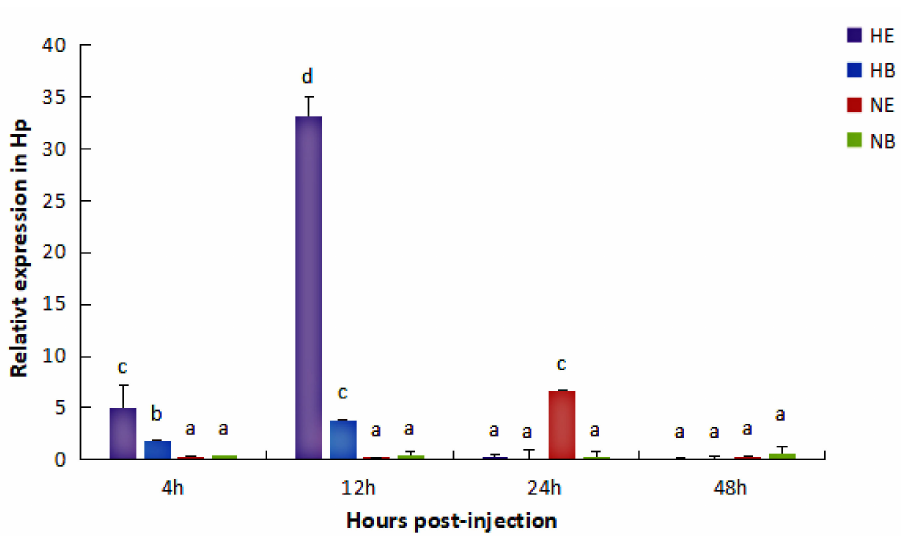
Figure 2. Expression level of HdHSP70 in Hp was detected by qRT-PCR. Abalones were maintained for 96 h at increased temperature (30 ◦ C) as thermal stress condition, after 96 h they were injected with 50 µ L of live V. parahaemolyticus (1.1 × 10 8 cfu/mL) (HE) or injected with 50 µ L of 0.9% NaCl (HB); Abalones were maintained for 96 h at normal temperature (25 ◦ C), after 96 h they were injected with 50 µ L of live V. parahaemolyticus (1.1 × 10 8 cfu/mL) (NE) or injected with 50 µ L of 0.9% NaCl (NB); Samples were collected at 4, 12, 24 and 48 h after injection. β -actin was selected as a reference gene. Values are means ± SD of biological replicates ( n = 6). The different letters (a, b, c, and d) on the error bars represent significant difference ( p < 0.05) between challenged and control group. HE: thermal stress and injected V. parahaemolyticus , HB: thermal stress and injected NaCl. NE: normal condition and injected V. parahaemolyticus , NB: normal condition and injected NaCl. Hp: